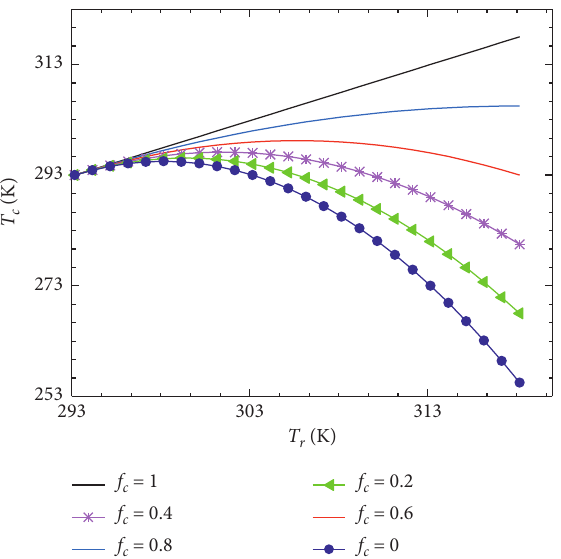
s ,min or T c ,min by 3K.